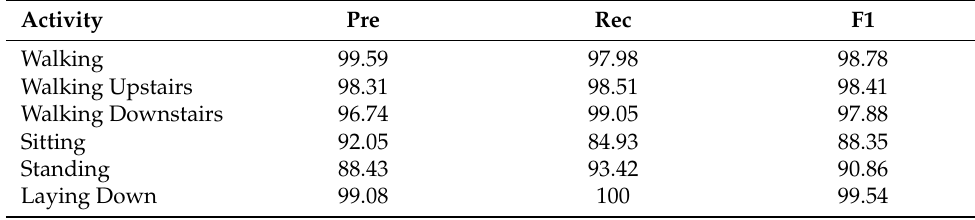
Table 10. Classification rates (%) of the best model of the UCI-HAR dataset using RF.